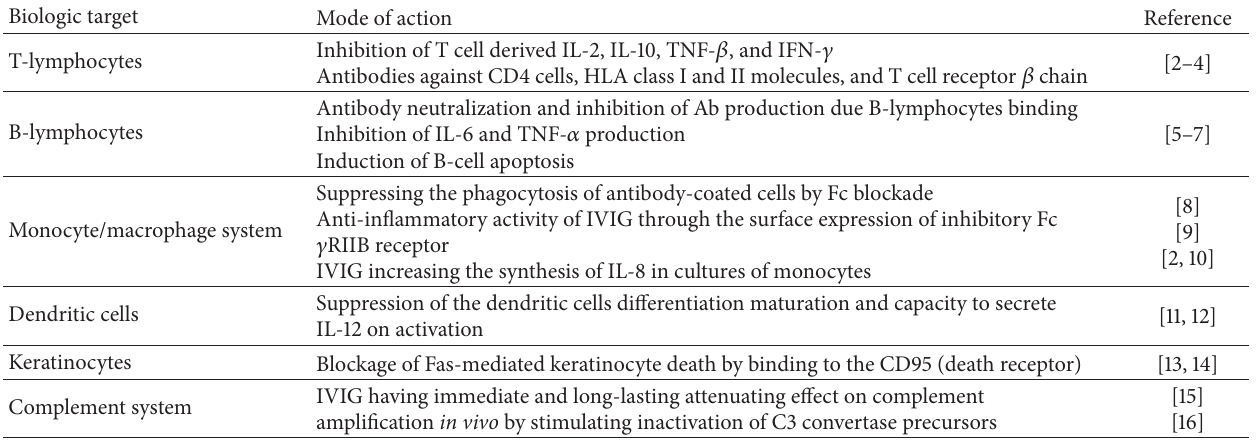
Table 1: Mechanism of action of IVIG in inflammatory and autoimmune